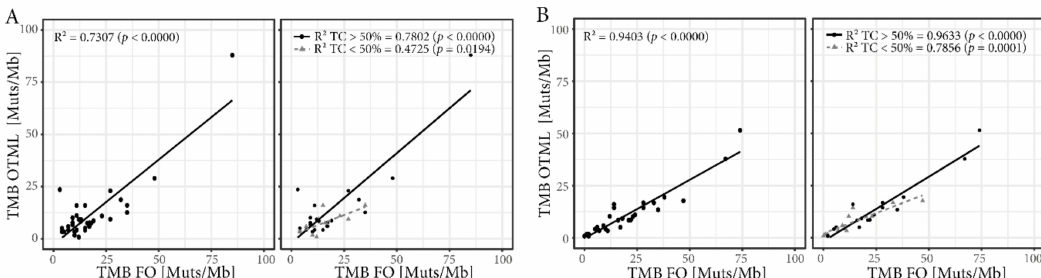
Figure 1. Correlation of tumor mutational burden (TMB) between the targeted sequencing panels. Correlation of TMB assessed by Oncomine TML (OTML) and by FoundationOne (FO) in NSCLC ( A ) and melanoma ( B ) (left panels). The correlation of the TMB is influenced by the percentage of tumor cells (TC) in the tissue sections for the respective samples (right panels) with a greater correlation in samples with a tumor cell ratio higher than